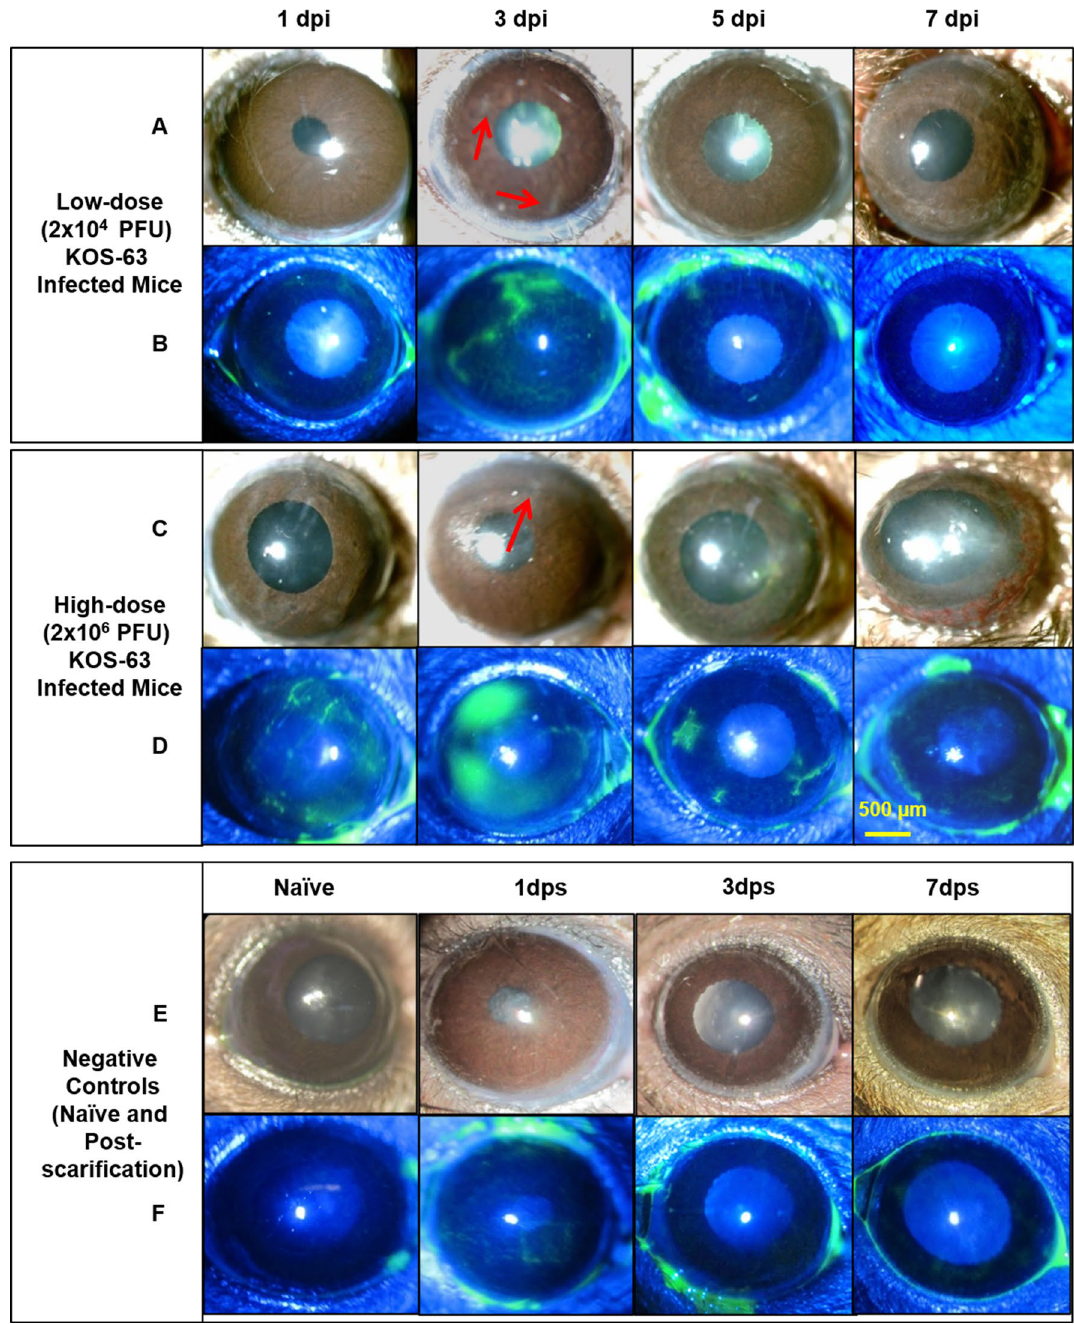
Figure 1. Representative slit-lamp photos following corneal inoculation with low dose (Ld, 2 × 10 4 PFU; A, B ), high dose (Hd, 2 × 10 6 PFU; C, D ) HSV-1 KOS-63 strain, and negative controls (naïve and sham-infected; E, F). Representative white light images from Ld ( A ) and Hd ( C ) inoculated corneas at 1, 3, 5, and 7 days post infection (dpi) demonstrate the corneal opacity at these time points. Hd HSV-1 infected mice developed more severe corneal opacity as compared to Ld infected mice. Red arrows are showing the opacity at 3 dpi. Representative cobalt blue filtered light images from Ld ( B ) and Hd ( D ) inoculated corneas demonstrate corneal epithelial defect following staining the corneas with 0.1% fluorescein at 1, 3, 5, and 7 dpi. In both Ld and Hd KOS-63 infected mice corneal epithelial defects peaked at 3 dpi. Representative white light ( E ) and blue filtered ( F ) corneal images in naïve and 1,3, and 7 days post scarification